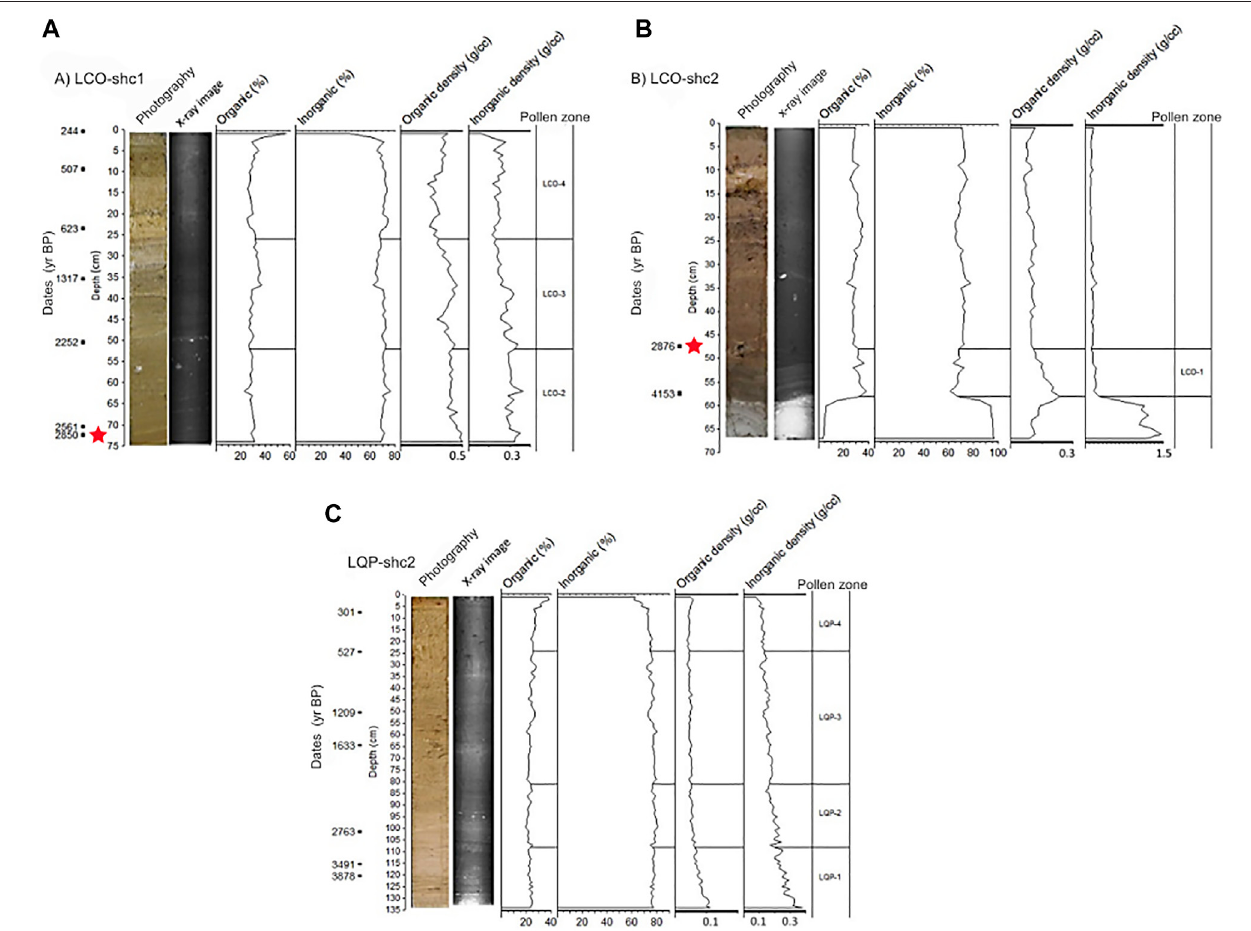
FIGURE 2 | Photographs, X-ray images, percentage and density of organic and inorganic matter, and radiocarbon ages of the cores from (A) Laguna Corralito LCO-shc1, and (B) Laguna Corralito LCO-shc2 (The LCO-shc2 is attached to the LCO-shc1 base from 48 cm). (C) Laguna Quebrada Parada LQP-shc2. The red star denotes the tie point between LCO-shc1 and